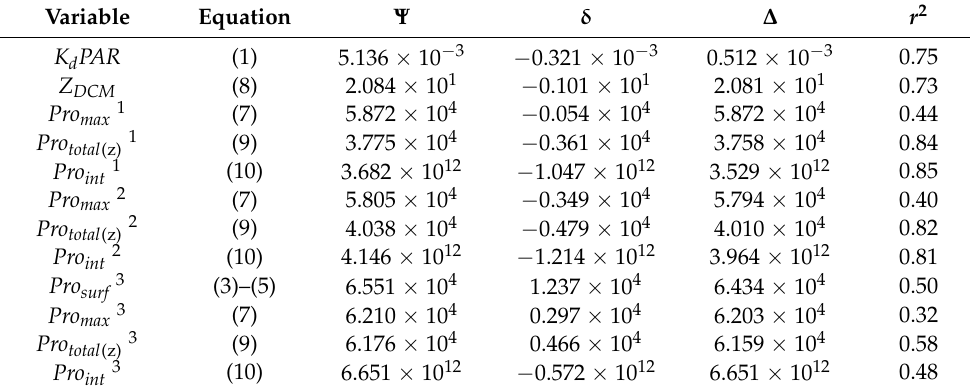
Table 3. Response variables with their respective root mean square error ( Ψ ), bias ( δ ), centre-root (unbiased) mean square error ( ∆ ), and determination coefficient ( r 2 ) when compared with in situ data from 13 AMT cruises. Variable definitions are listed in Table 1. Variable